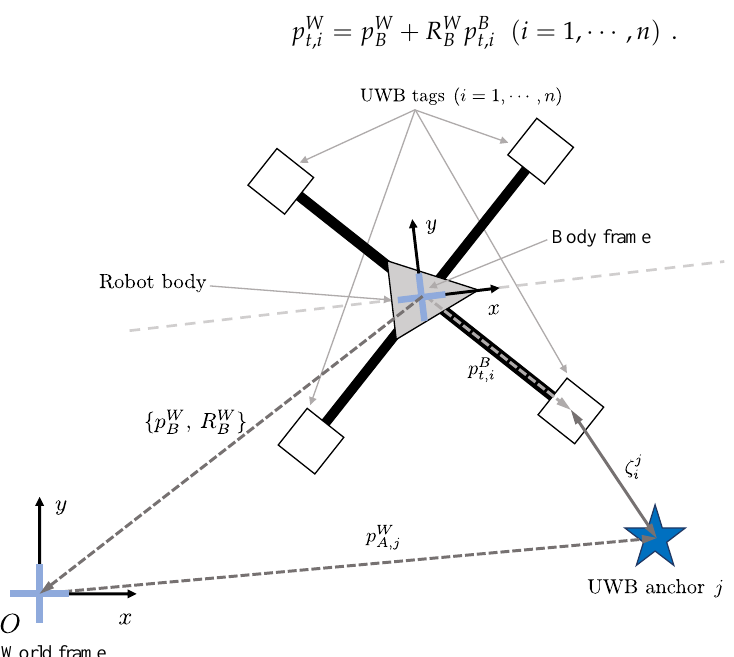
Figure 1. Illustration of the coordinate